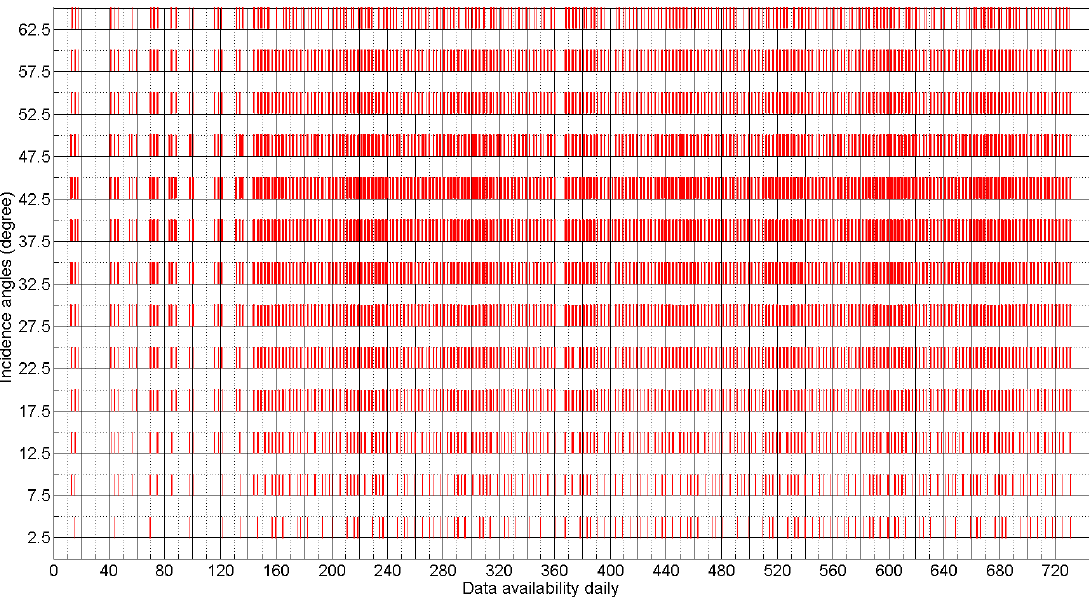
Figure 3. SMOS- T b s data availabilities. It is noted that the available dates for the horizontal and the vertical polarisations are the same; therefore, only one is shown